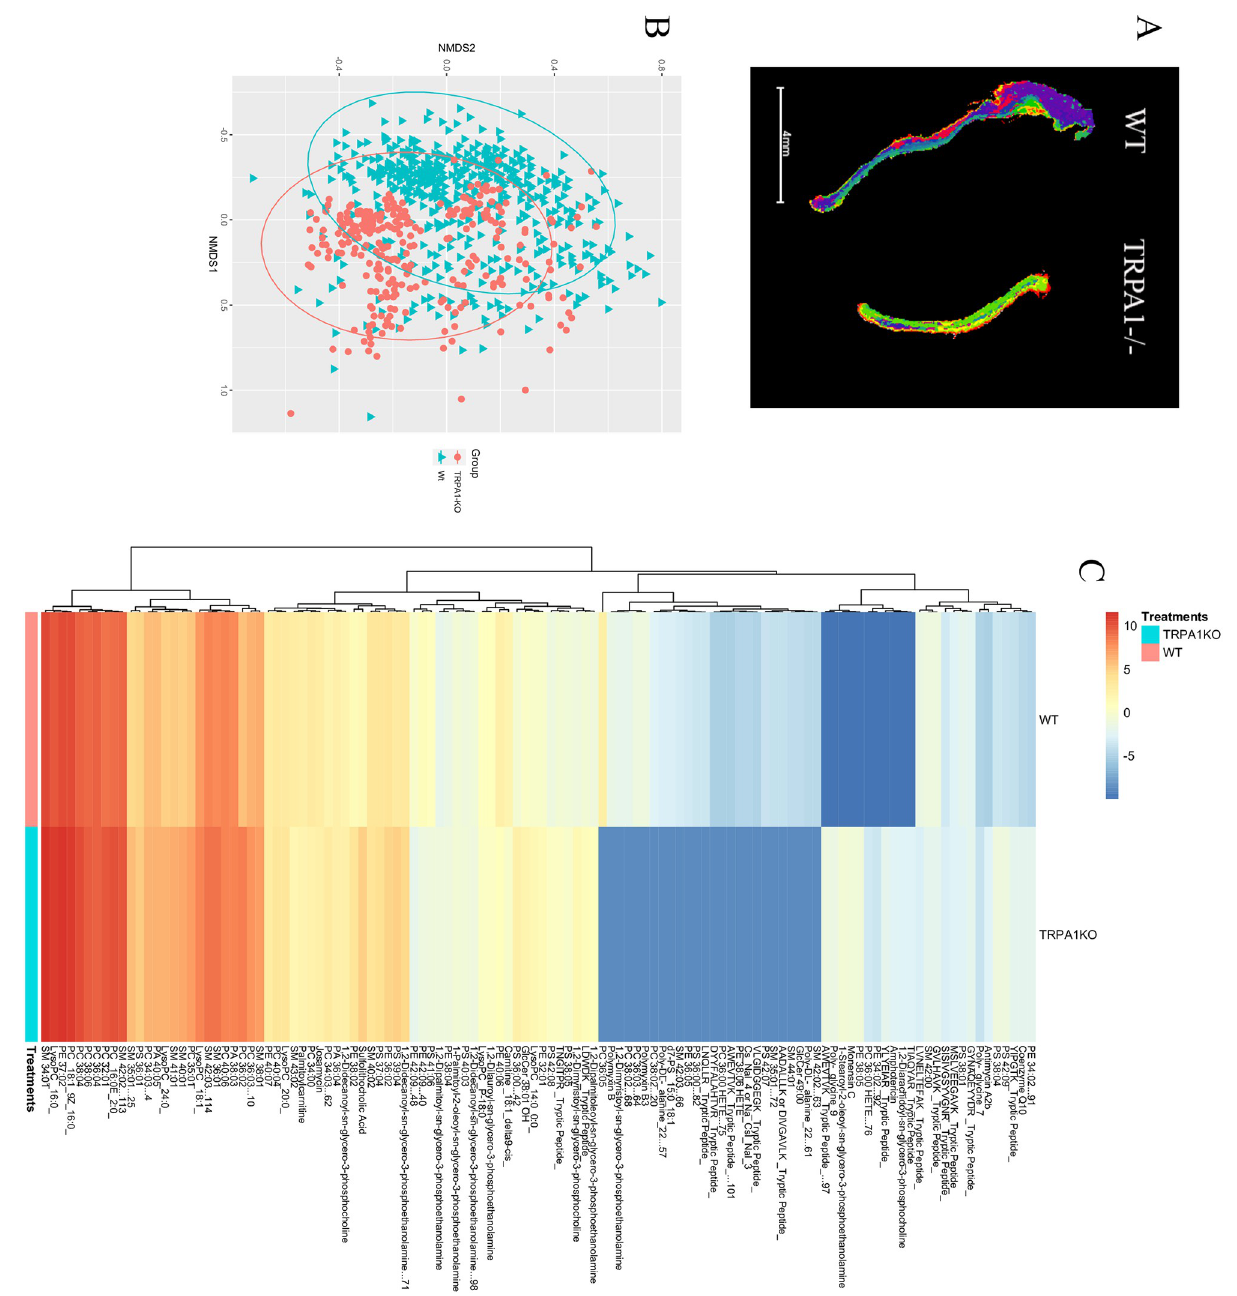
Fig 3. TRPA1 -/- have differing metabolic response to TDI exposure. Ears from mice treated with TDI as in Fig 1 were collected and examined by imagine mass spec. (A) Segmentation for representative ear, (B) NMDS similarly plot, and all of the metabolites that were identified by both m/z and collisional cross section (C) are shown. Data represent three independent experiments and calculated as NMDS (B) or ANOVA (C). WT = wild type